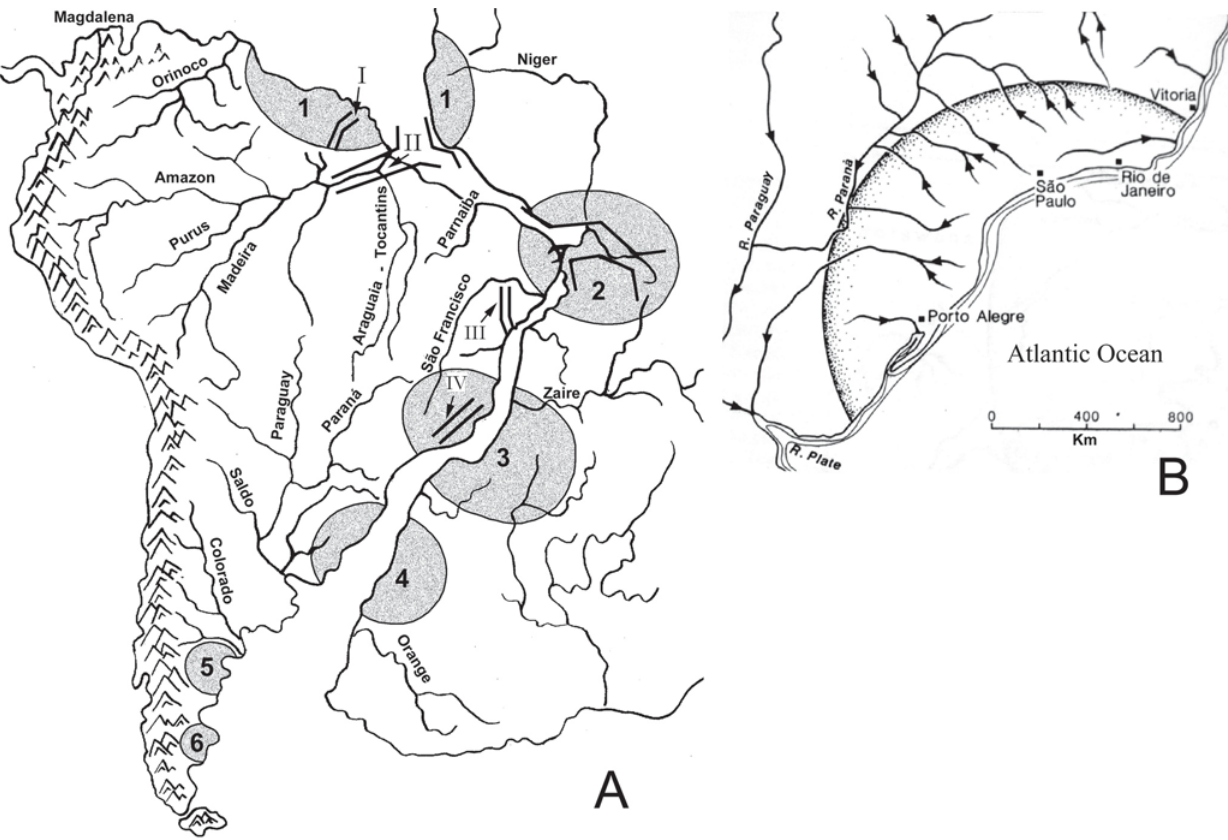
Fig. 3 . Rivers and uplifts of Atlantic South America. A) break-up uplifts (megadomes) and associated principal rifts. Megadomes: Guyana/Guinea (1), NE Brazil/Niger (2), Mantiqueira/Angola (3), Uruguay/SW Africa (4), Somuncurá (5) and Deseado (6). Break-up rifts: Tacutu (I), Foz do Amazonas (II), Reconcavo Tucano-Jatobá (III) and Taubaté (IV). B) detail of the uplift from the Southeastern Brazil (from Cox, 1989 and Potter,